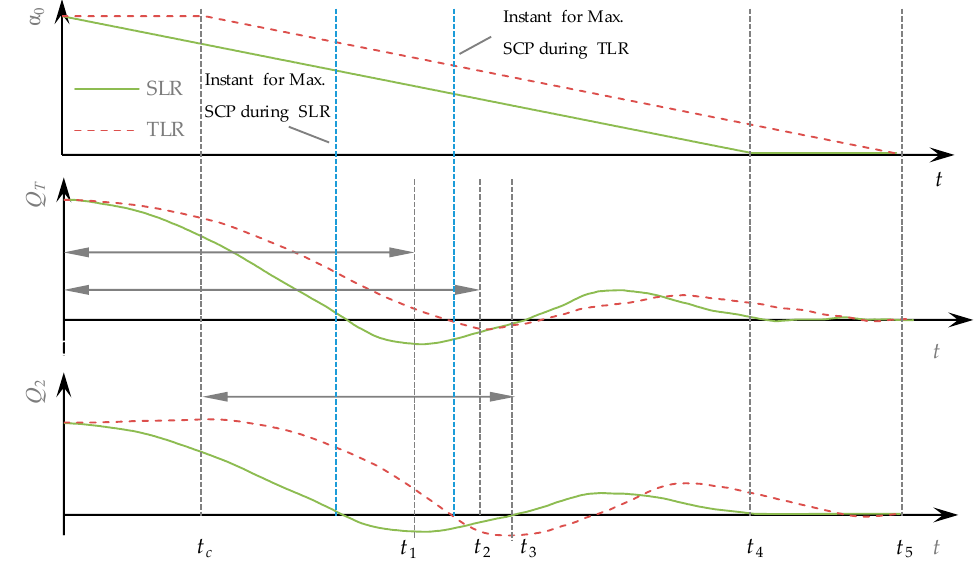
Figure 3. Schematic of wicket gate opening, discharge of the main and branch pipes during simultaneous load rejection (SLR) and two-stage load rejection (TLR).